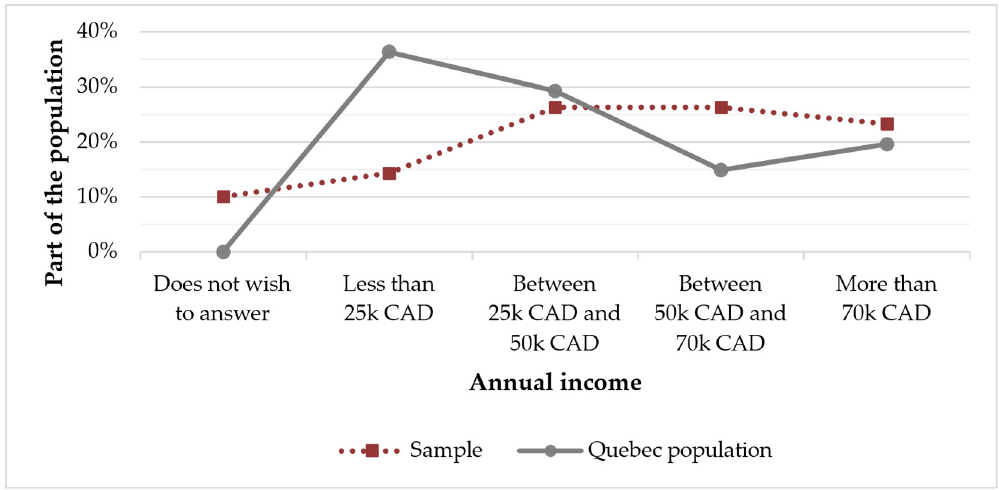
Figure 1. Annual income of the sample compared to the Quebec population [65].